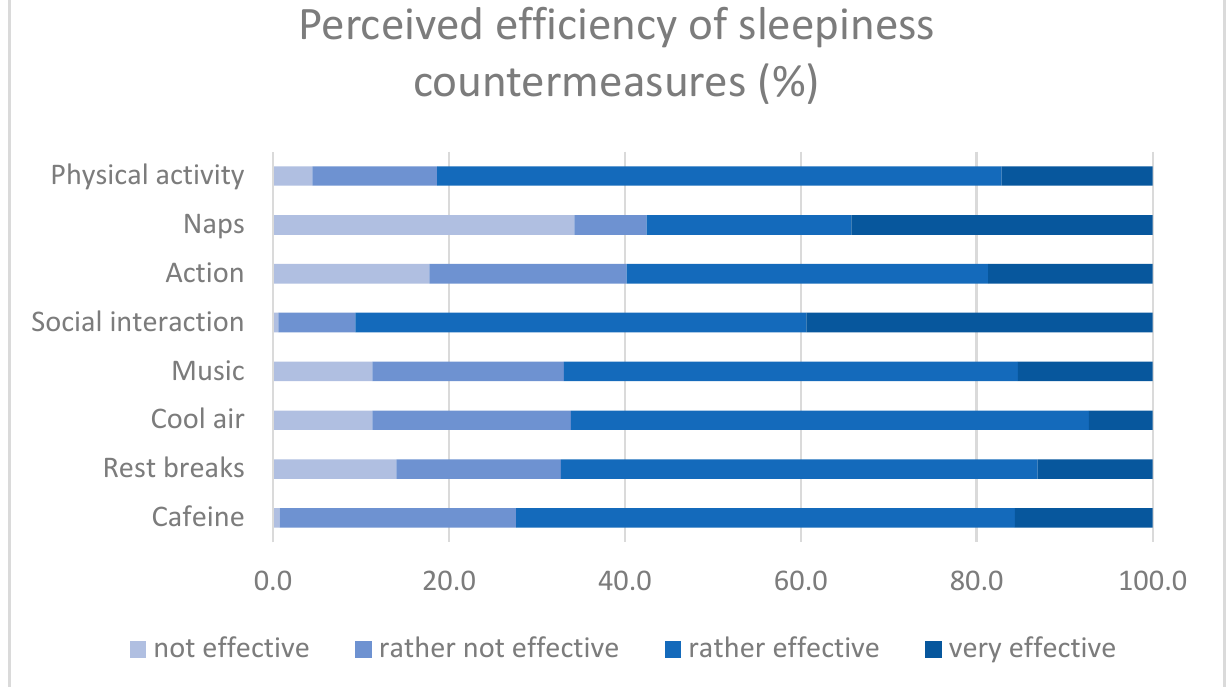
Figure 3. Frequency distribution for the perceived efficiency of sleepiness countermeasures.